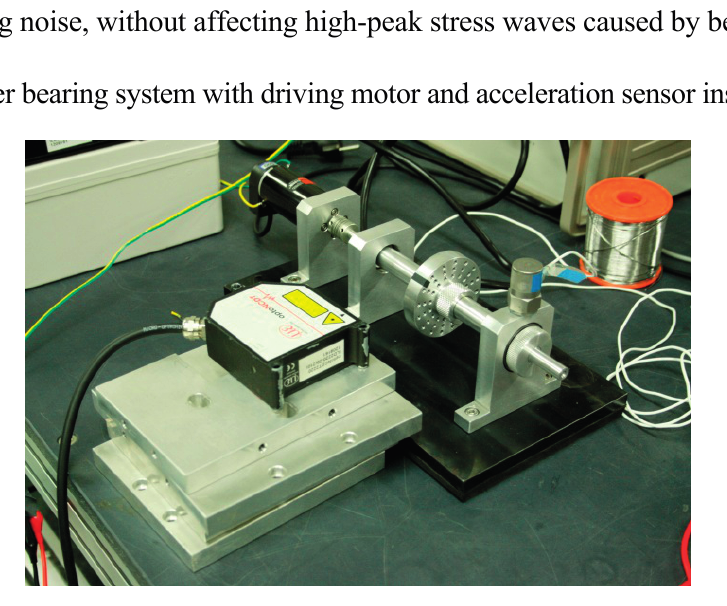
Figure 3. Schematic drawing of the experimental setup for the roller bearing